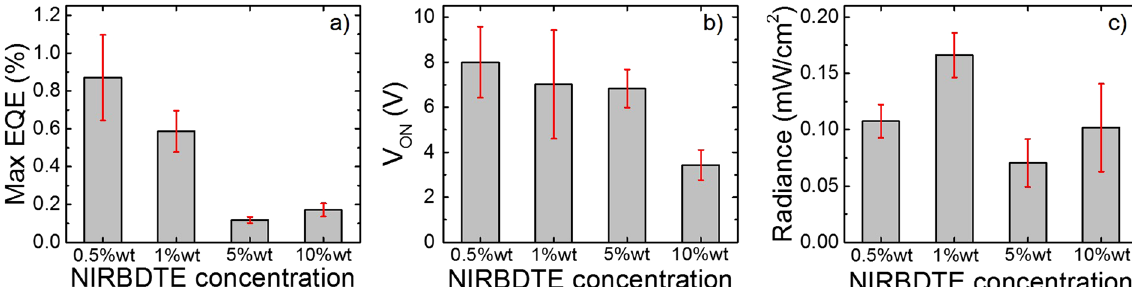
Figure 3. Mean and the related standard deviation (in red) of ( a ) the maximum external quantum efficiency (EQEs), ( b ) the turn-on voltage (V ON ) and ( c ) the radiance of PLEDs incorporating different concentration of NIRBDTE (0.5%, 1%, 5% and 10% wt) in blend with F8BT as host material for a set of 8 devices. V ON is the voltage at which the emission is ~10 times the noise level and the radiance is the light intensity (mW/cm 2 ) at the saturation of the